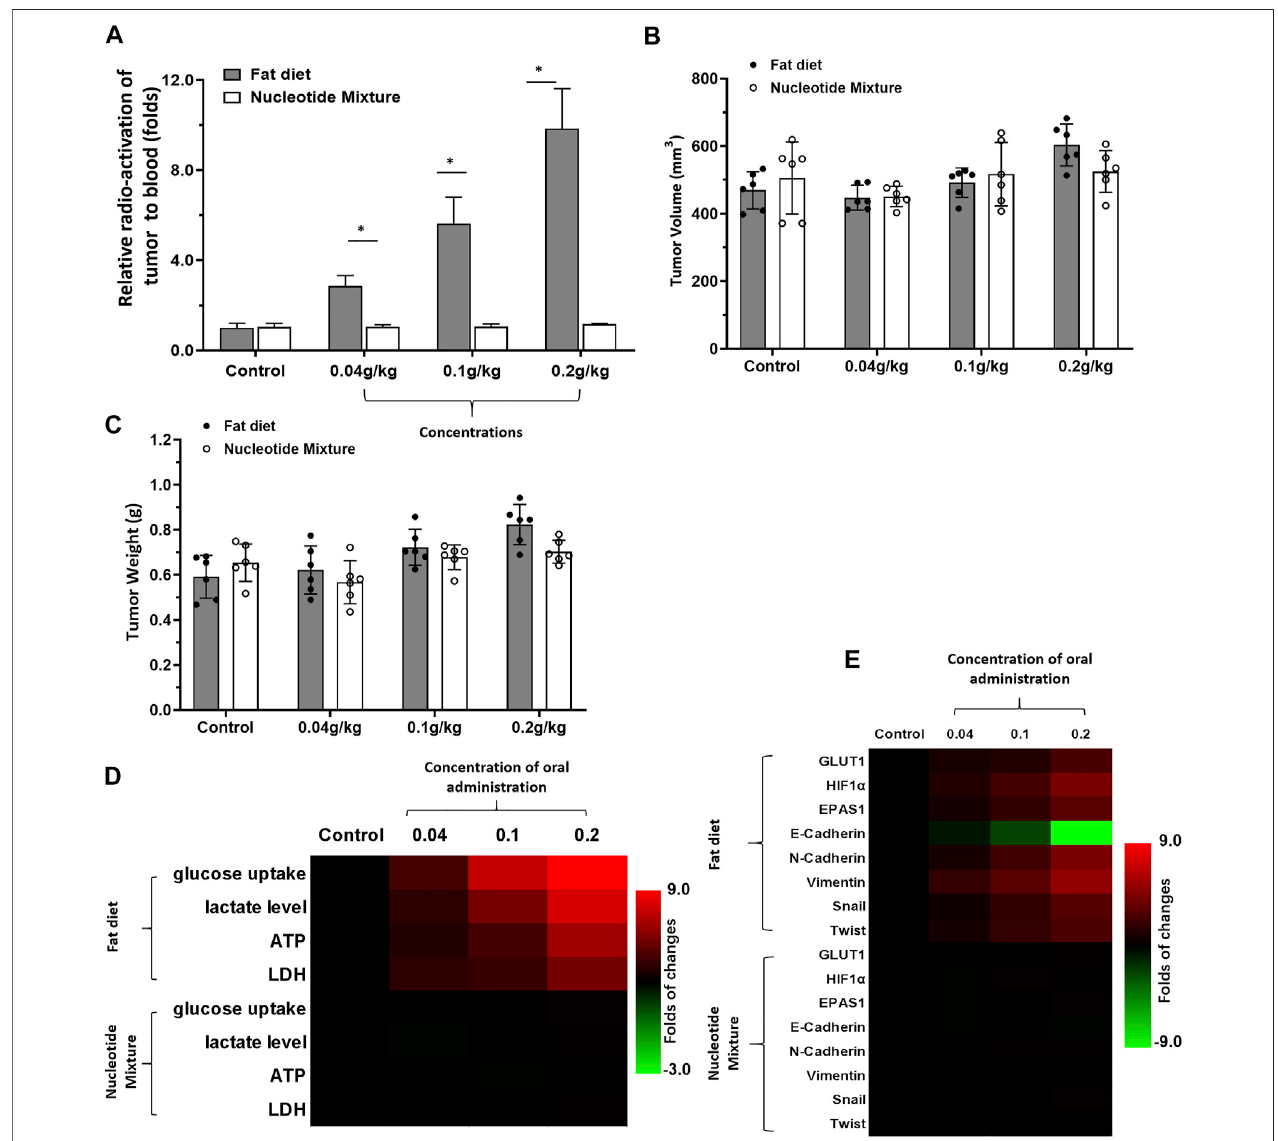
FIGURE1| Detection ofthemetabolic status ofMHCC97-H cellsinSCIDmice byalipid emulsionand theSNM. MHCC97-H cellswereobtainedbyculture. Then, cells were inoculated intoSCID mice subcutaneously. Afterthe formation oftumor tissue,the Nuclide uptakeexperiments wasdone on SCIDmice. Thenuclide intensity of HCC tumor tissues folds to blood was shown as Histogram (A) . Tumor tissues were collected and the tumor volume (B) and tumor weight (C) shown as histograms. The level of metabolism-related indicators (D) and Warburg effect-related factors (E) in tumor tissues are shown as heatmaps. * p < 0.05.